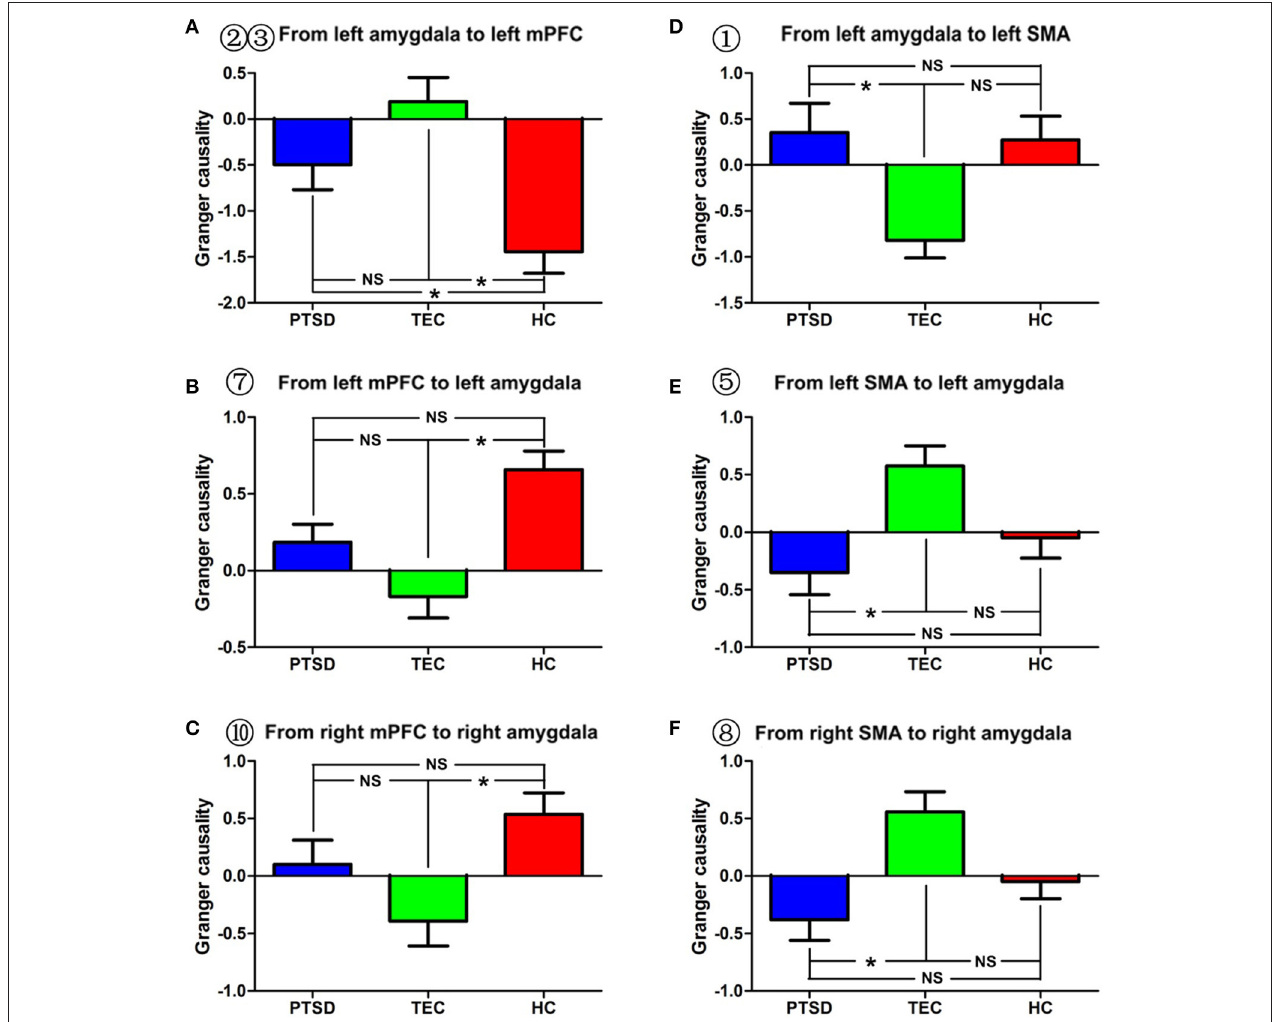
FIGURE 2 | Effective connectivity between the amygdala and the mPFC and between the amygdala and the SMA in the different groups. (A–C) indicate inter-group differences regarding the influence of the amygdala on the mPFC and the influence of the mPFC on the amygdala. (D–F) indicate inter-group differences regarding the influence of the amygdala on the SMA and the influence of the SMA on the amygdala. PTSD, post-traumatic stress disorder group; TEC, trauma-exposed control group; HC, healthy control group; vmPFC, ventral media prefrontal cortex; SMA, supplementary motor area. “*” means having significant difference between the two